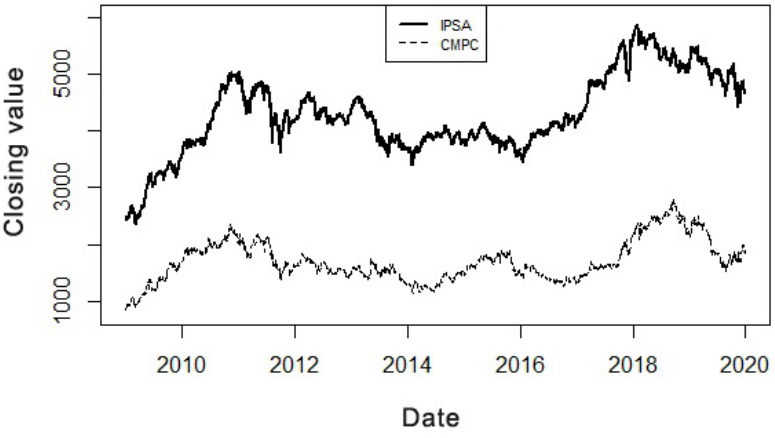
Figure 5. Plots of the CMPC and IPSA daily closing prices for December 2008 to December 2019.